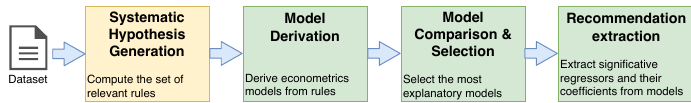
Figure 1. Depiction of the phases of the proposed